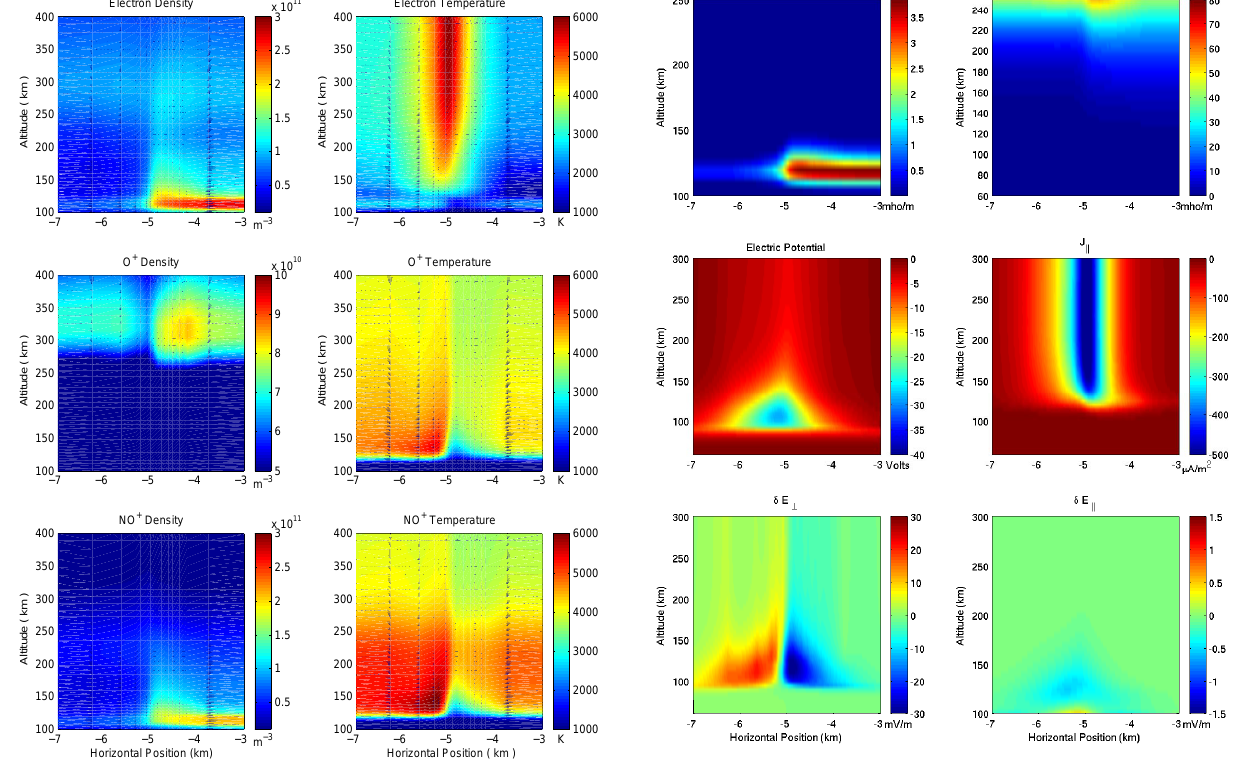
Fig. 7. Same as in Fig. 3, but with the addition of E -region wave heating of electrons, following the prescription proposed by Robin- son (1986).